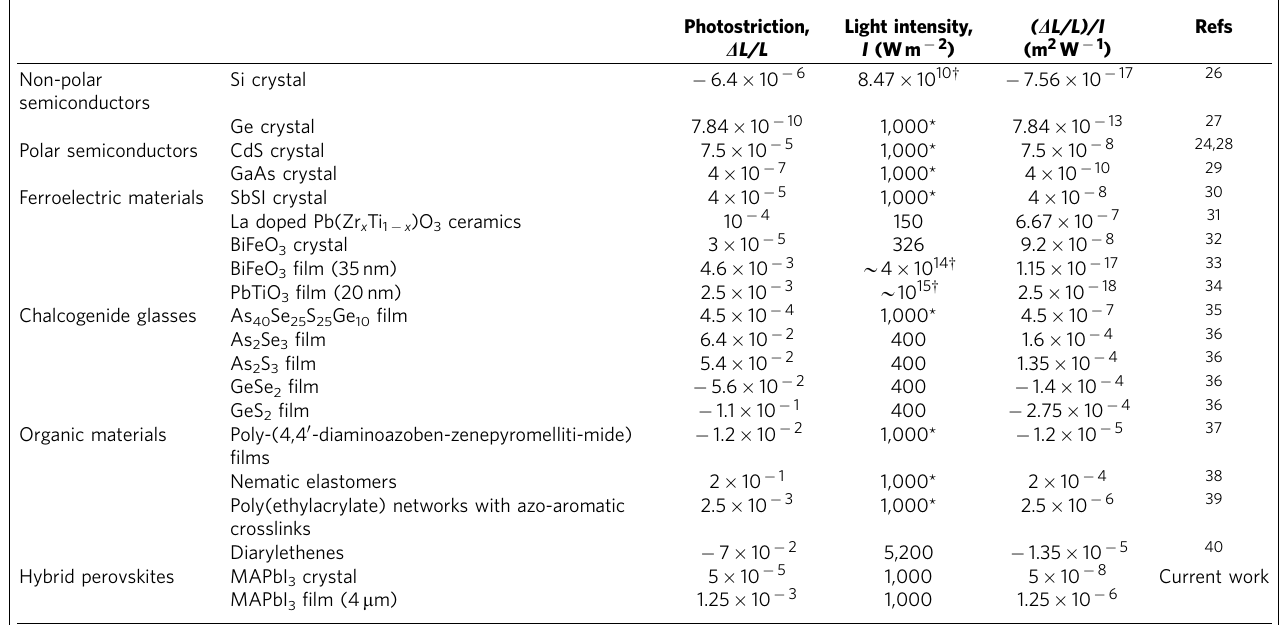
Table 1 | Photostrictive coefficients of different materials.